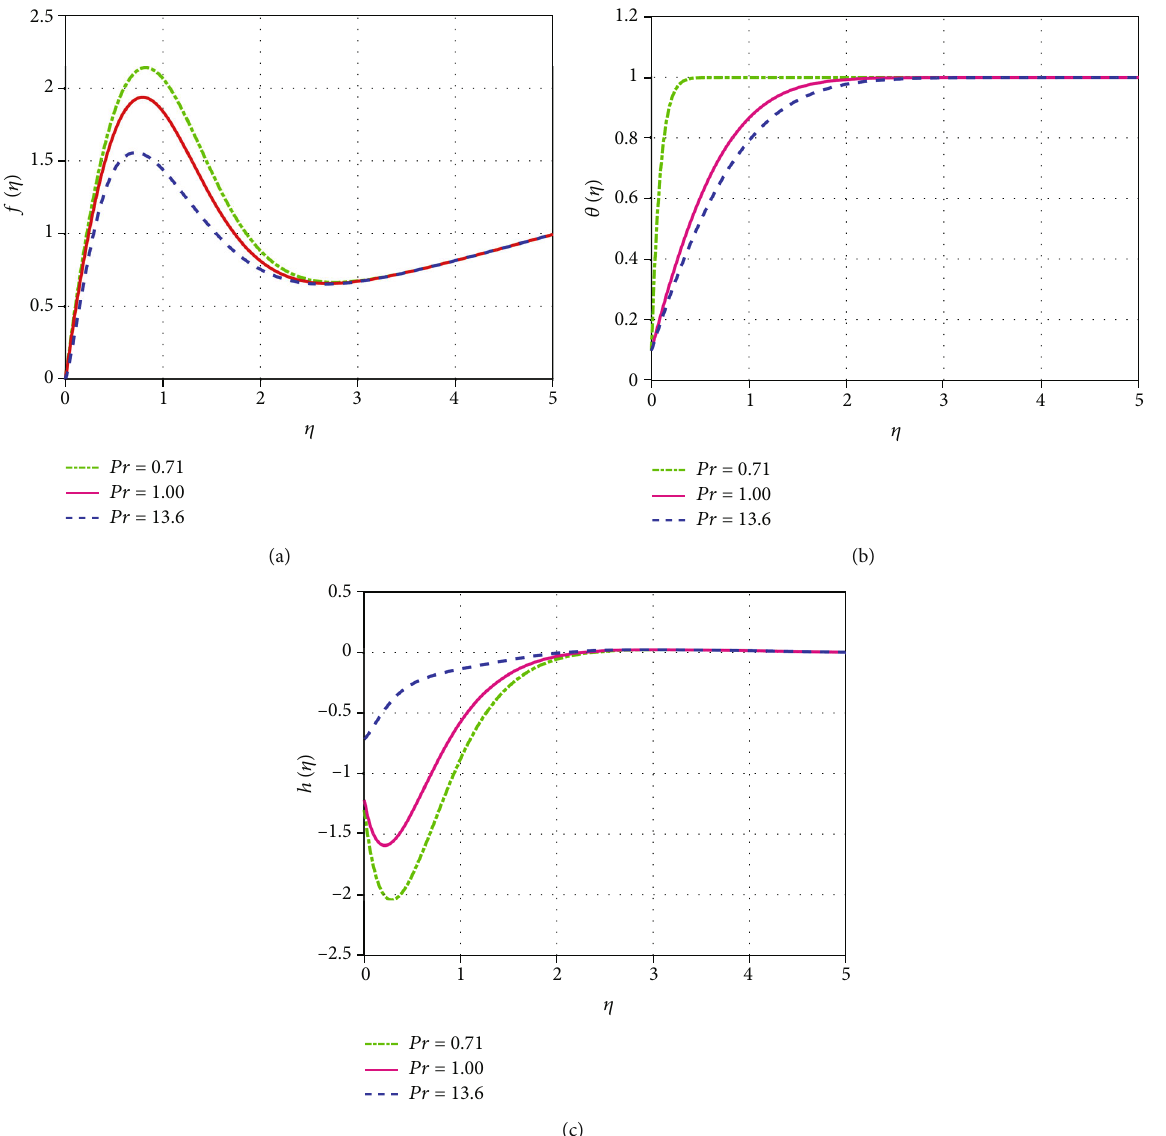
Figure 3: (a) Velocity, (b) temperature, and (c) micro-rotation pro fi les with constant values of γ = 45 ° , M =2, c =0.5, R =0.5, Sc =0.22, L =0.33, λ =1, ξ =3, K =0.5, Gr =10, Gc =10 for Prandtl number 1 1